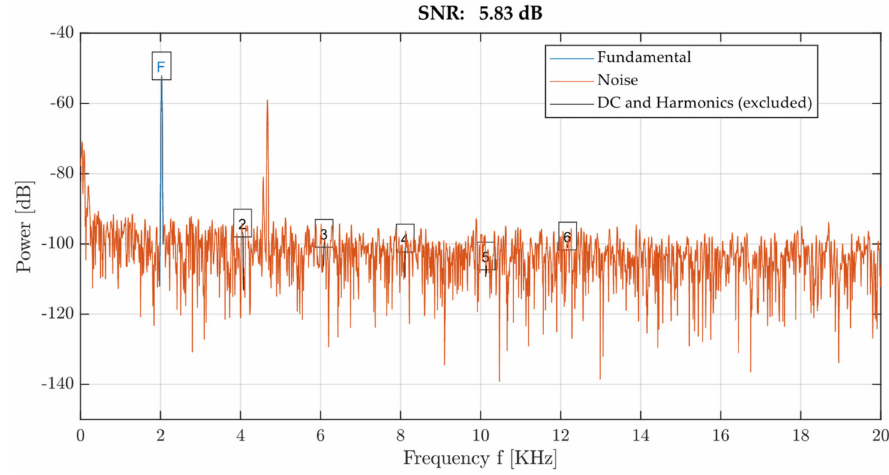
Figure 10. Illustration of signal-to-noise ratio function